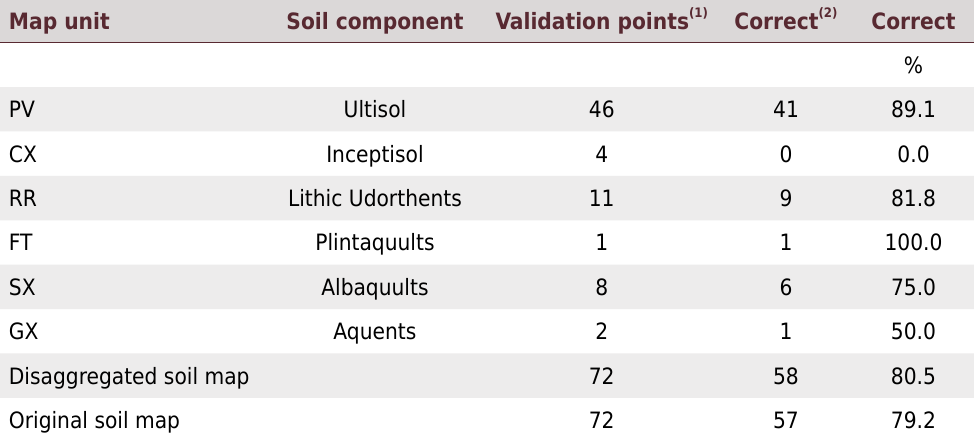
Table 4. Soil component and disaggregated map accuracies, assessed by the intersection with the available pedons Map